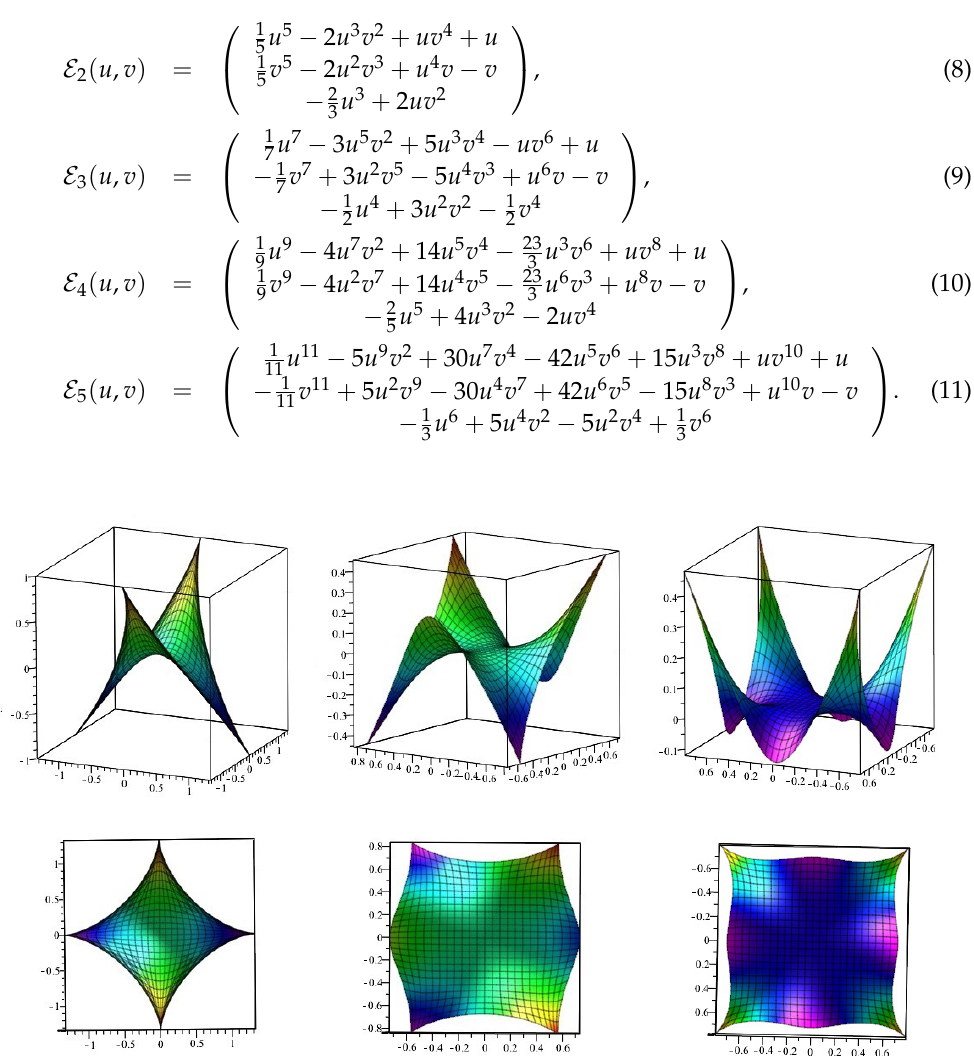
Figure 2. Enneper maximal surfaces ( Left ): E 1 ( u , v ) , ( Middle ): E 2 ( u , v ) , ( Right ): E 3 ( u , v )